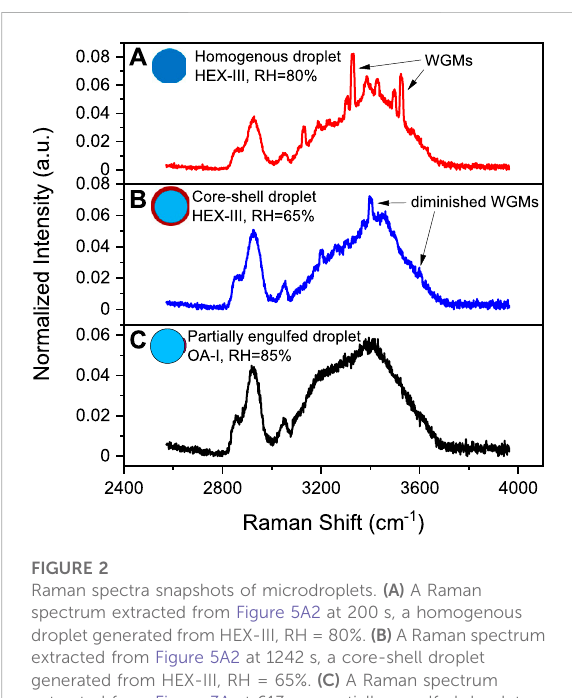
FIGURE 1 Schematic of the laser tweezers Raman spectroscopy (LTRS) system. A laser beam passes through a pair of beam expansion optics and fi nally couples into an objective to form the laser tweezers. The droplet is imaging using a 470 nm illumination LED and a high frame rate camera. The Raman spectra of the trapped droplets are recorded using a spectrograph/CCD. M1 and M2 are mirrors. D is a long pass dichroic mirror.